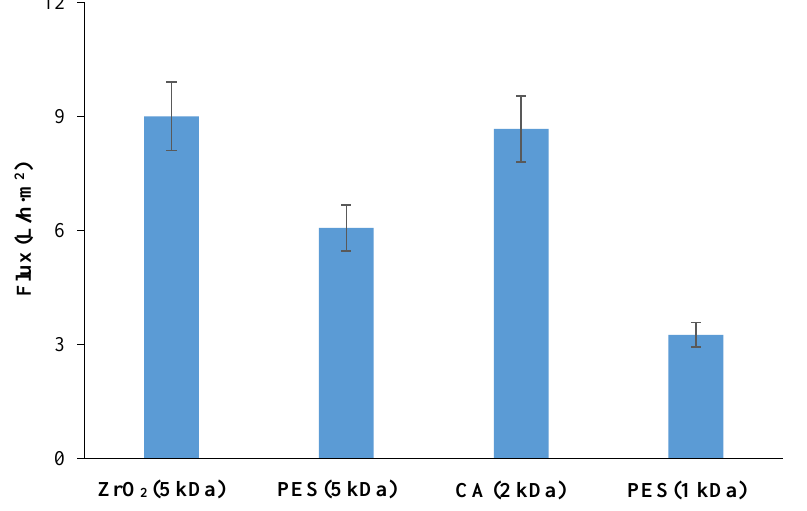
Figure 6. Constant permeate flux (VRF: 2) obtained by using ceramic (ZrO 2 ), polyethersulfone (PES) and cellulose acetate (CA) membranes.